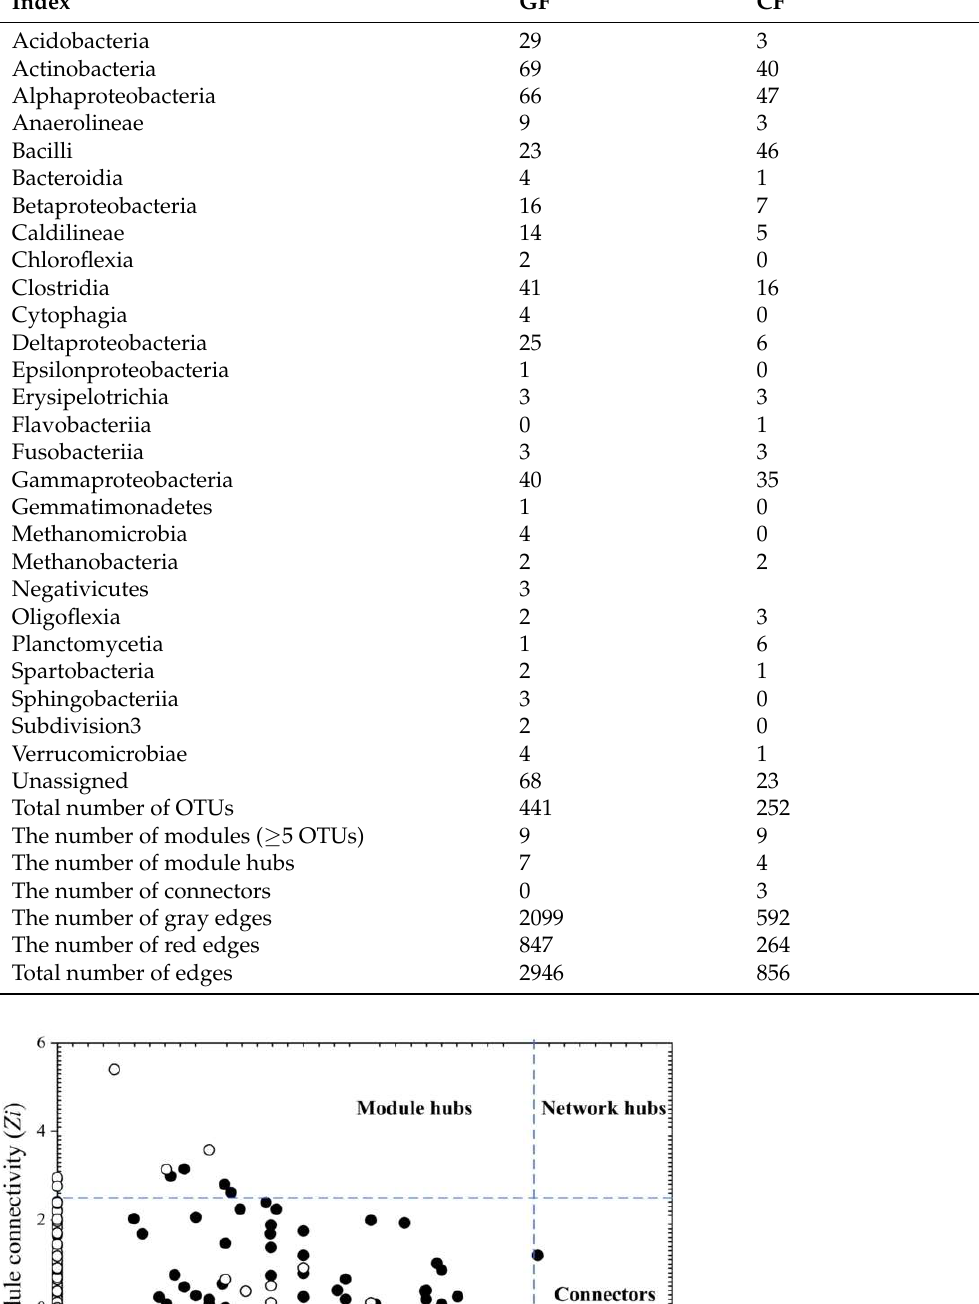
Table 2. The composition of the ecological network.